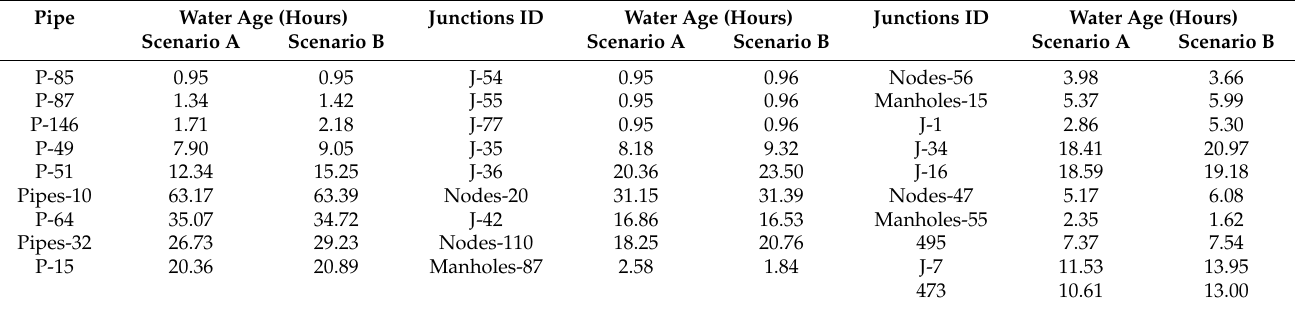
Table 2. Pipes and nodes selected for the illustration of chlorine behavior and their water ages (after simulated time of 288